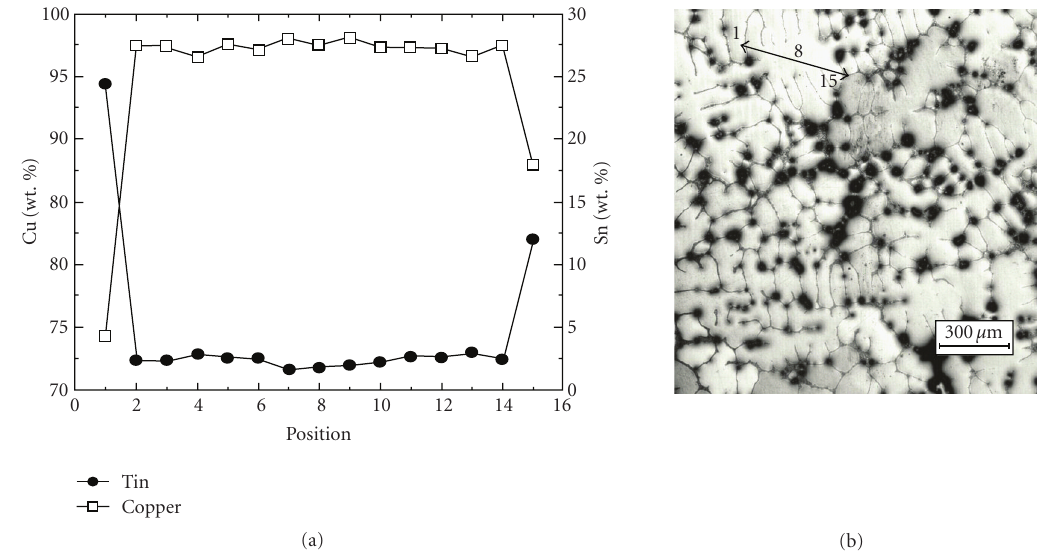
Figure 5: (a) Composition profile through a dendrite cross section in Cu-5Sn-5Pb alloy that was quenched from the monotectic temperature. (b) Micrograph of a dendrite cross section in Cu-5Sn-5Pb alloy that was quenched from the monotectic temperature.